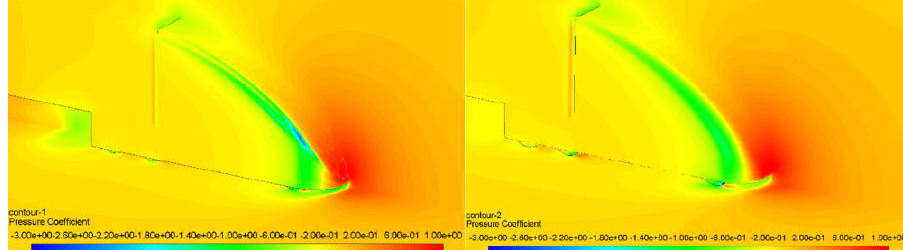
Fig. 13. Comparison of pressure coefficient between Concept Two baseline (left), and Concept Two - Revision A (right).